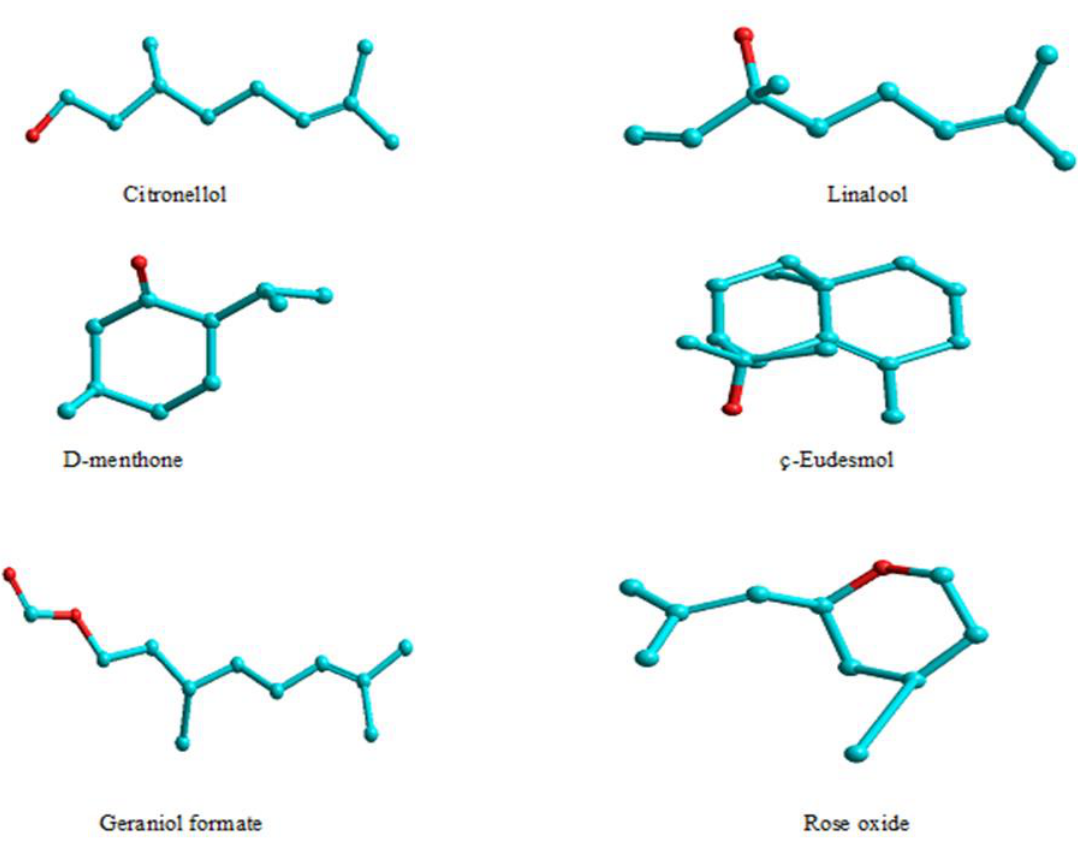
Figure 3. The optimized structures of the studied constituents using Modified Neglect of Diatomic Overlap (MNDO) method at ground state.